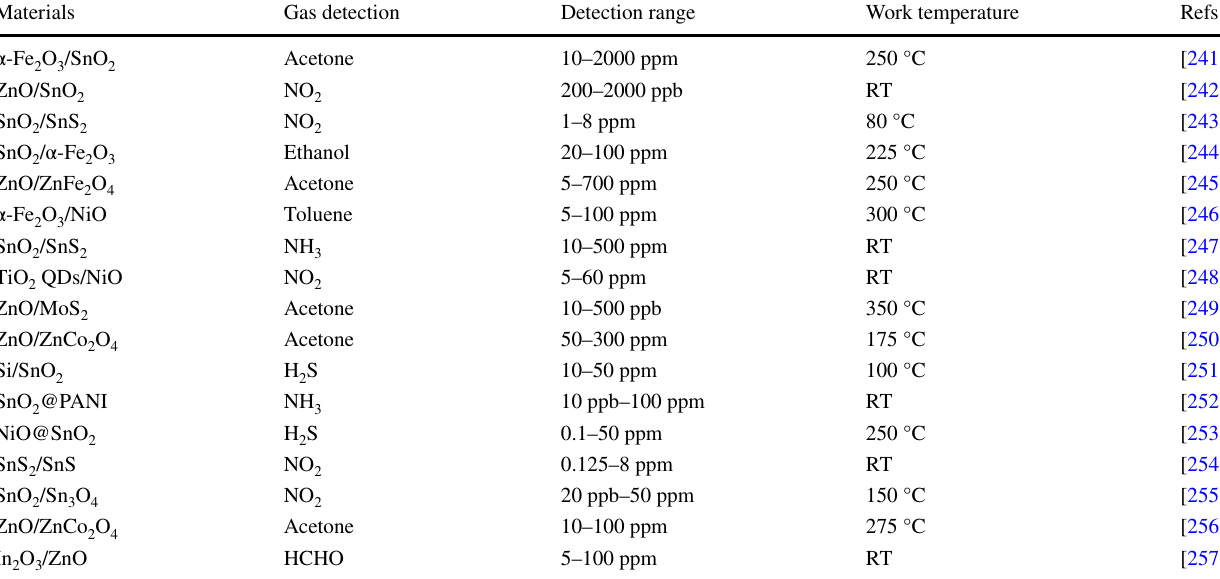
Table 4 Representative works based on heterojunctions Materials